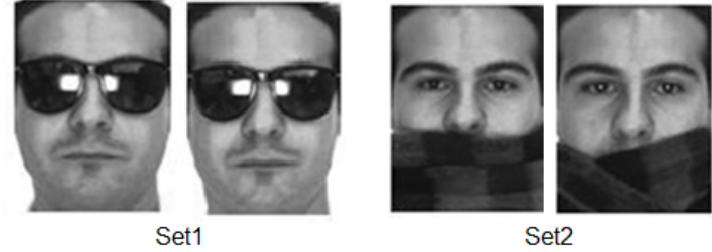
Figure 8. Example of testing images from the AR